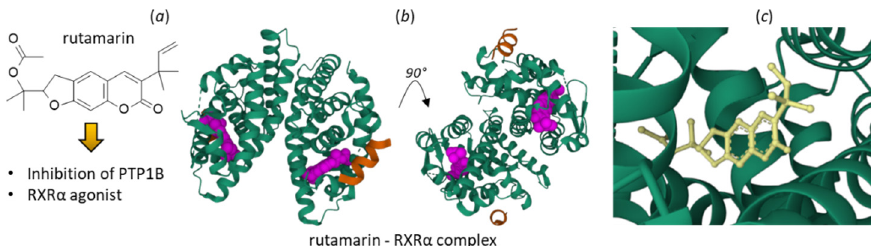
Figure 7. ( a ) Structure of rutamarin and ( b ) its binding to human retinoic X receptor alpha (RXR α ). The alkaloid (purple) is bound to the protein dimer (green), in the presence of a SRC1 peptide (orange). ( c ) A close-up view of rutamarin in the RXR α active site (from PDB structure 3PCU) [78].